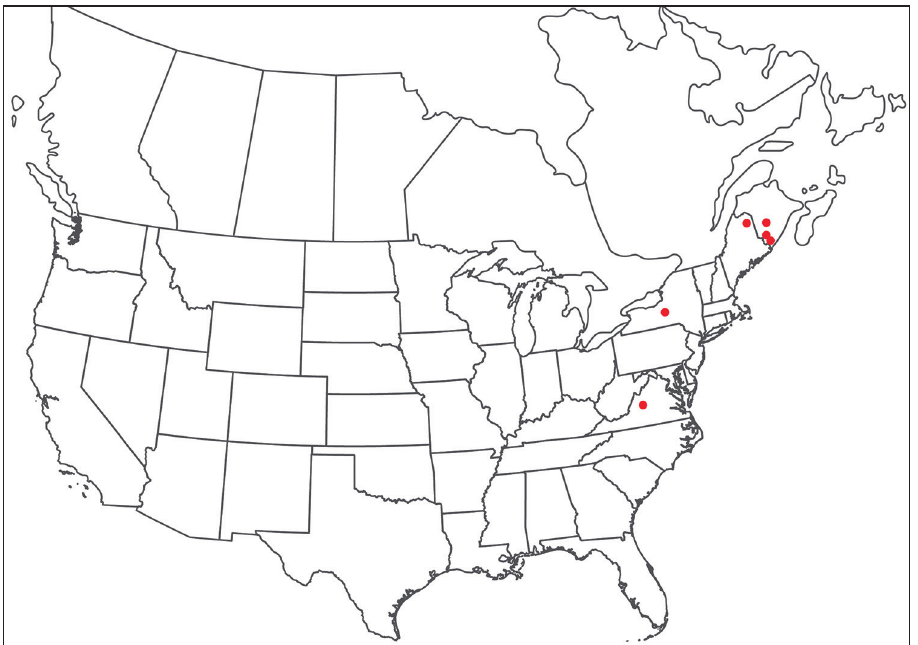
Figure 72. Torrenticola erectirostra sp. n.